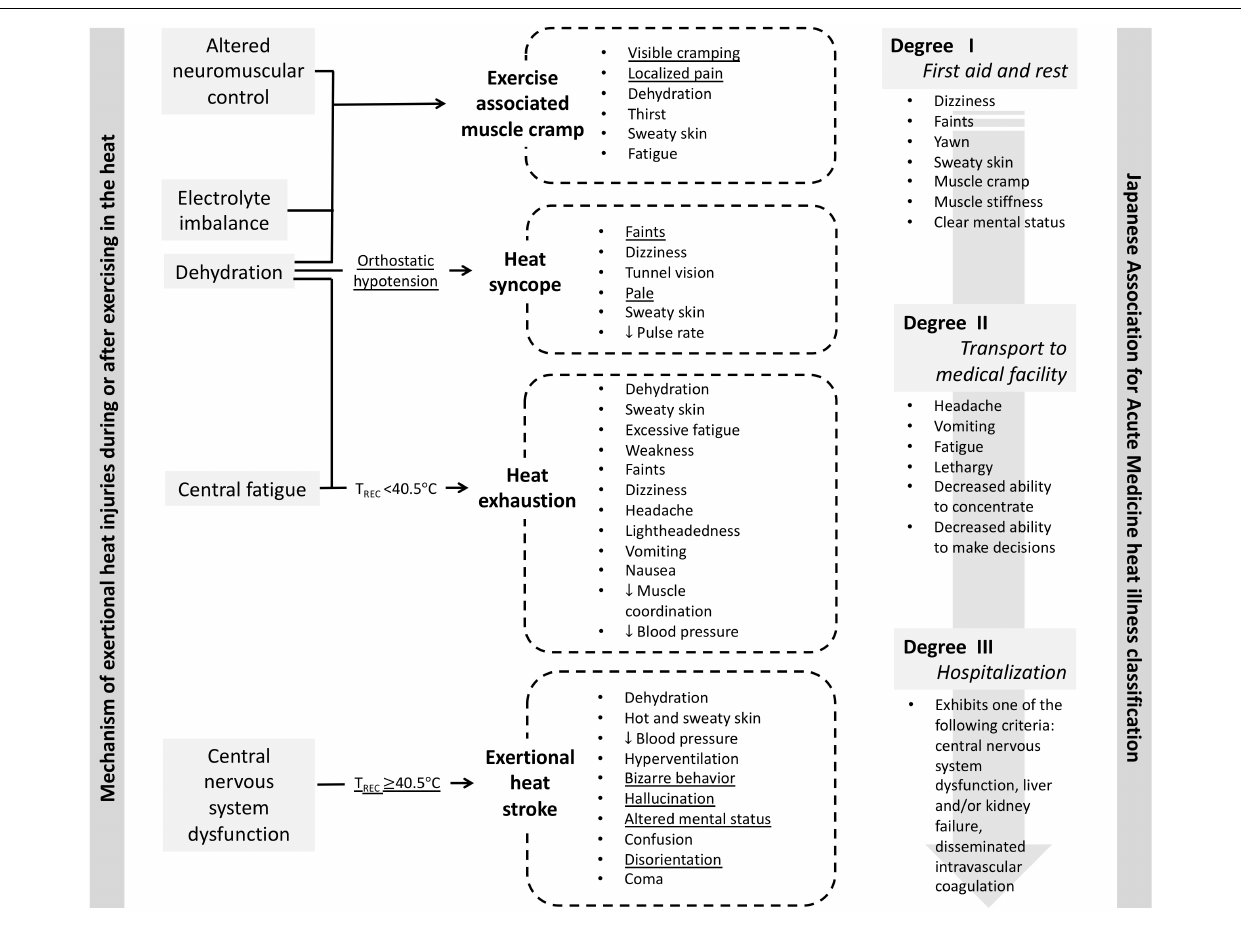
FIGURE 1 | Comparison of the exertional heat illness classification by mechanism (i.e., etiology-based classification; Casa et al., 2015) and by severity of clinical signs and symptoms (Japanese Association for Acute Medicine, 2015). Underlined signs and symptoms may serve as the diagnostic criteria for respective exertional heat illness when the context supports the development of exertional heat illness (i.e., moderate to high environmental condition, physical activity with high metabolic